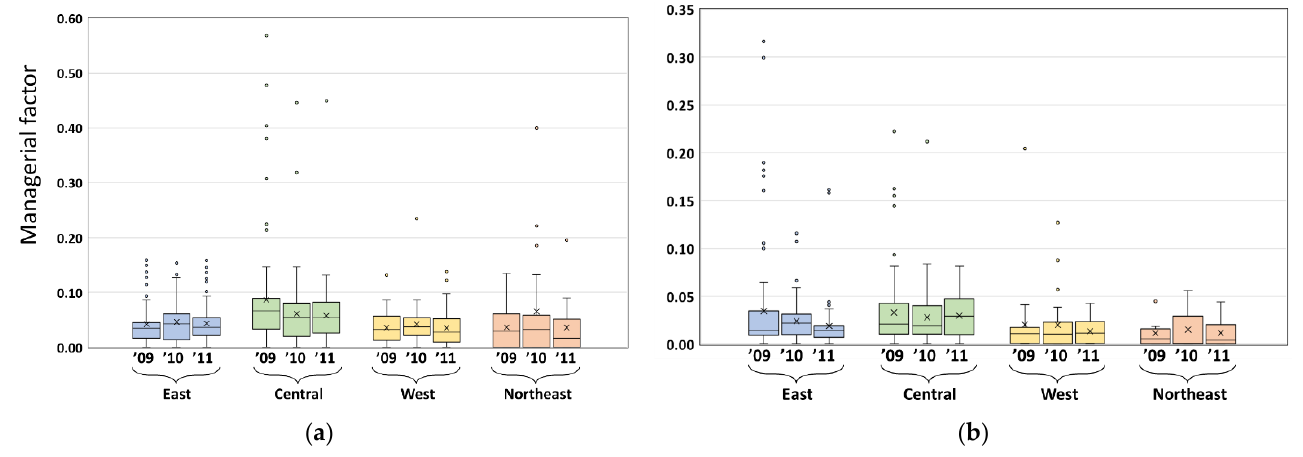
Figure 6. Boxplots of managerial factors in ( a ) the SM group and ( b ) the LARGE group by year and region. ’09, ’10, and ’11 refer to the years 2009, 2010, and 2011, respectively. “ × ” and “ ◦ ” stand for the average value and outliers, respectively.